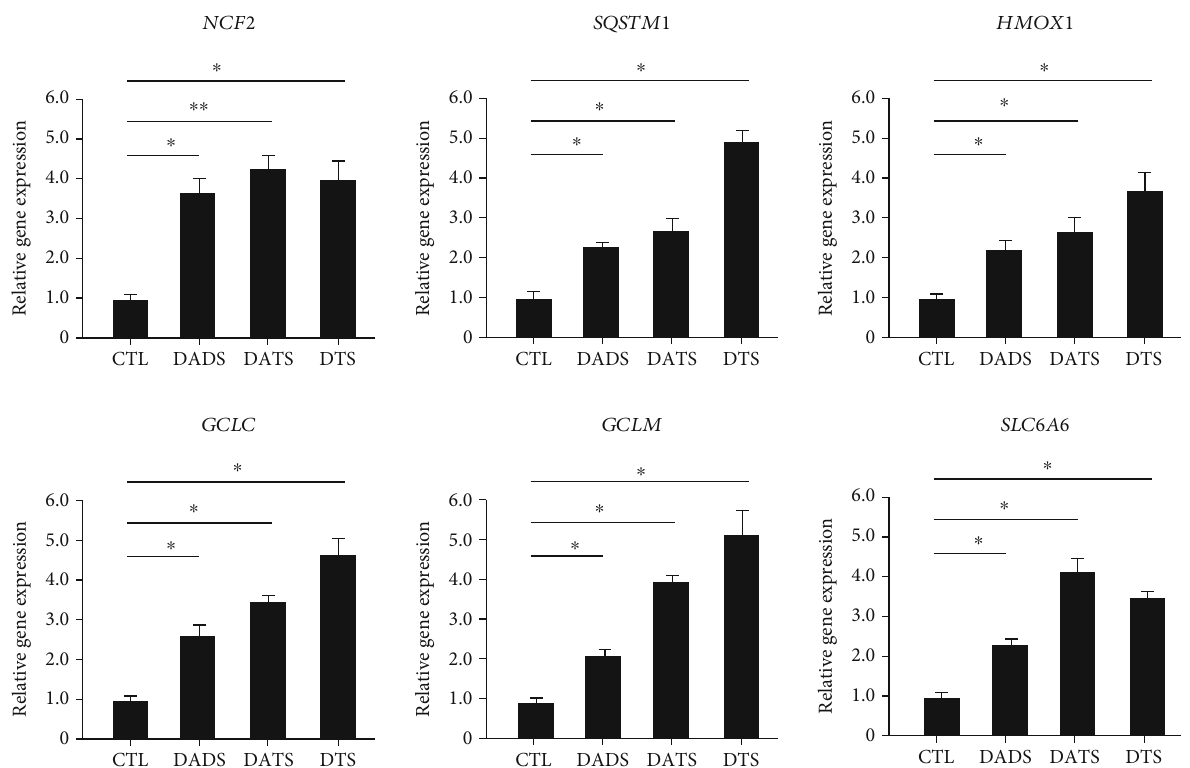
Figure 1: RT-PCR results of typical genes in HepG2 cells treated with DADS/DATS/DTS.